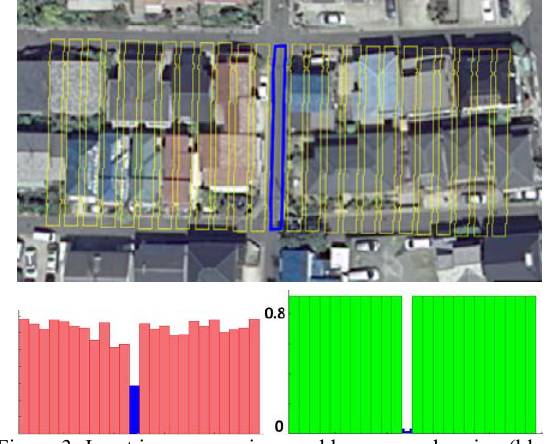
Figure 3: Input image superimposed by one road region (blue) and 24 non-road regions (yellow). Lower left: the computed SSH scores over the profile index. Lower right: and an optimal SSH configuration.